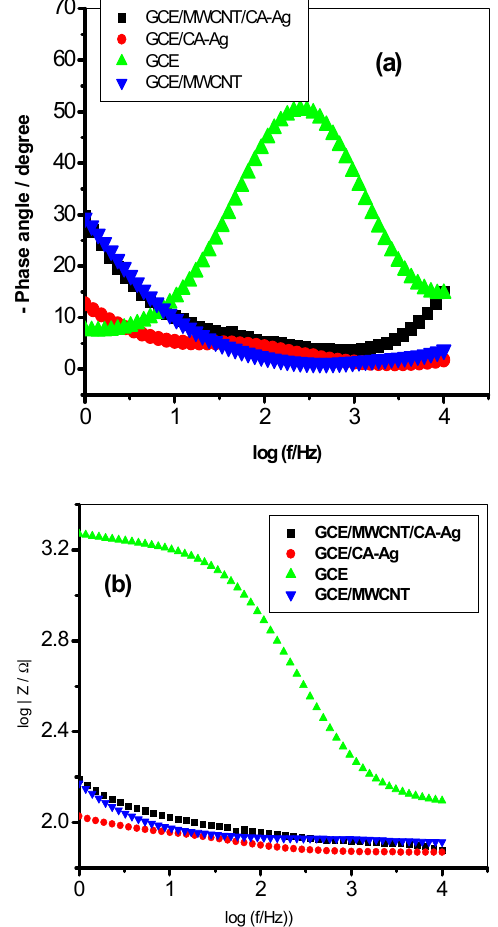
Figure 8. Bode plots obtained for some of the electrodes, showing ( a ) the plots of phase angle/deg. log (f/Hz)) and ( b ) the plot of log |Z/ Ω | vs. log vs. log (f/Hz)) and ( b ) the plot of log |Z/ Ω | vs. log (f/Hz).